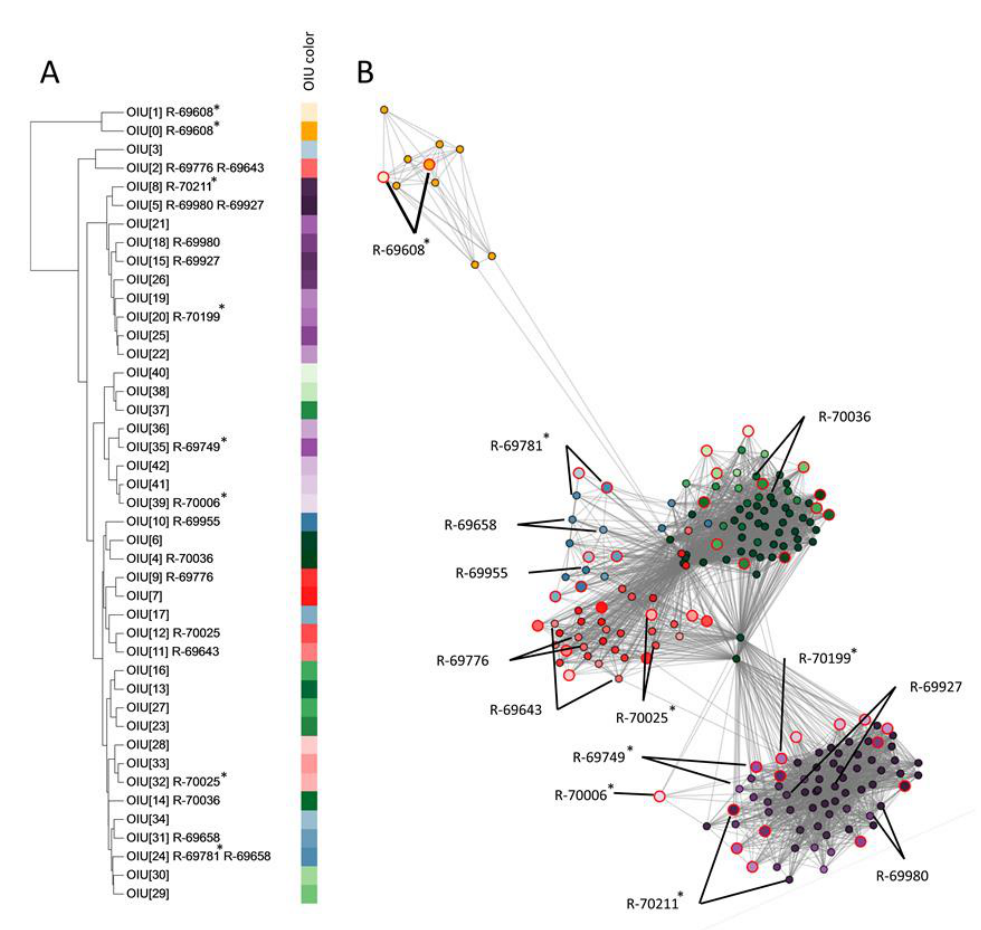
Figure 3. Comparison of hierarchical clustering versus network analysis on a case study dataset of 134 soil isolates. ( A ) Hierarchical clustering dendrogram of 43 reference spectra (UPGMA clustering algorithm) using the relative distance in the number of detected USFs. Aside from the corresponding OIU number, strains selected for further genomic analysis of which their spectra were matched to the OIU are indicated. ( B ) Network analysis based on all zero USFs elements (edges) of the USF matrix. Individual nodes are colored according to OIU number, as depicted in panel ( A ). The reference spectrum of each OIU is highlighted with large node sizes and red marking ( B ). The nodes of the spectra of each strain selected for further genomic analysis are marked by black lines ( B ). Strains that were chosen as a reference are indicated with * ( A ).